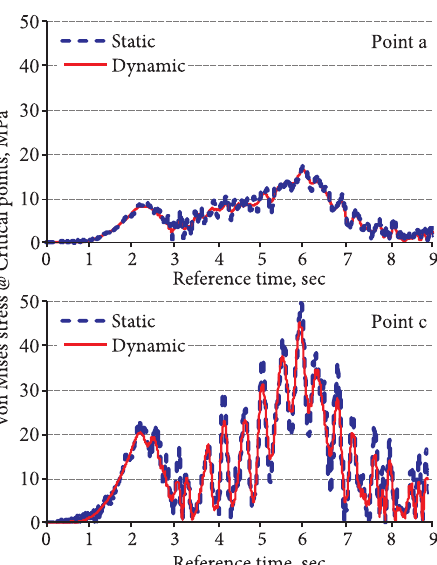
Fig. 7. Simulated stress time history based on static and dynamic loading, in Pa